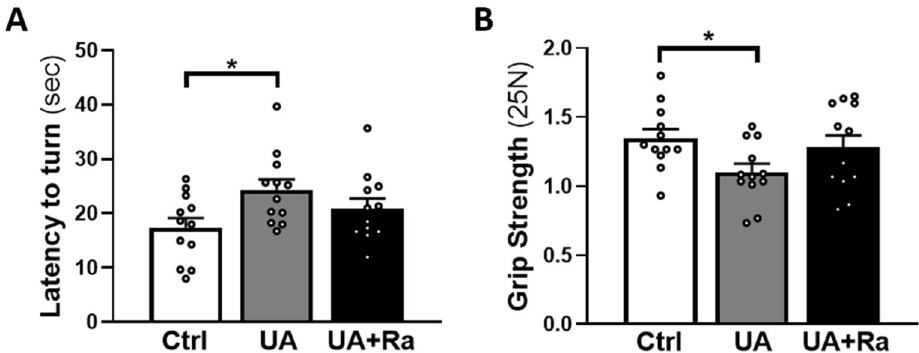
Figure 6. Impaired motricity following UA exposure during gestation. At PND7, prenatal inflammation induced a delay in turnaround time in the inclined plane in pups exposed to uric acid ( A ). At PND15, pups exposed in-utero to uric acid were weaker as evaluated by the grip strength test ( B ). N = 6 litters/group. *p < 0.05 Results presented as mean ± SEM. Statistical analysis by one-way ANOVA with Tukey’s multiple comparisons test with GraphPad Prism 9.2.0 (GraphPad Software, CA); www. graph pad.